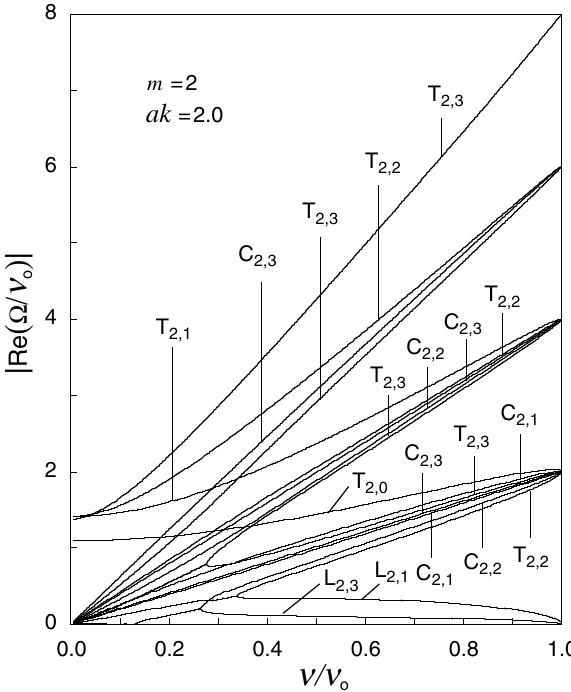
FIG. 8. Absolute value of the real part of (cid:13) =(cid:10) quadrupole modes as a function of (cid:10)=(cid:10) 1 : 5 , and zero wall impedance.